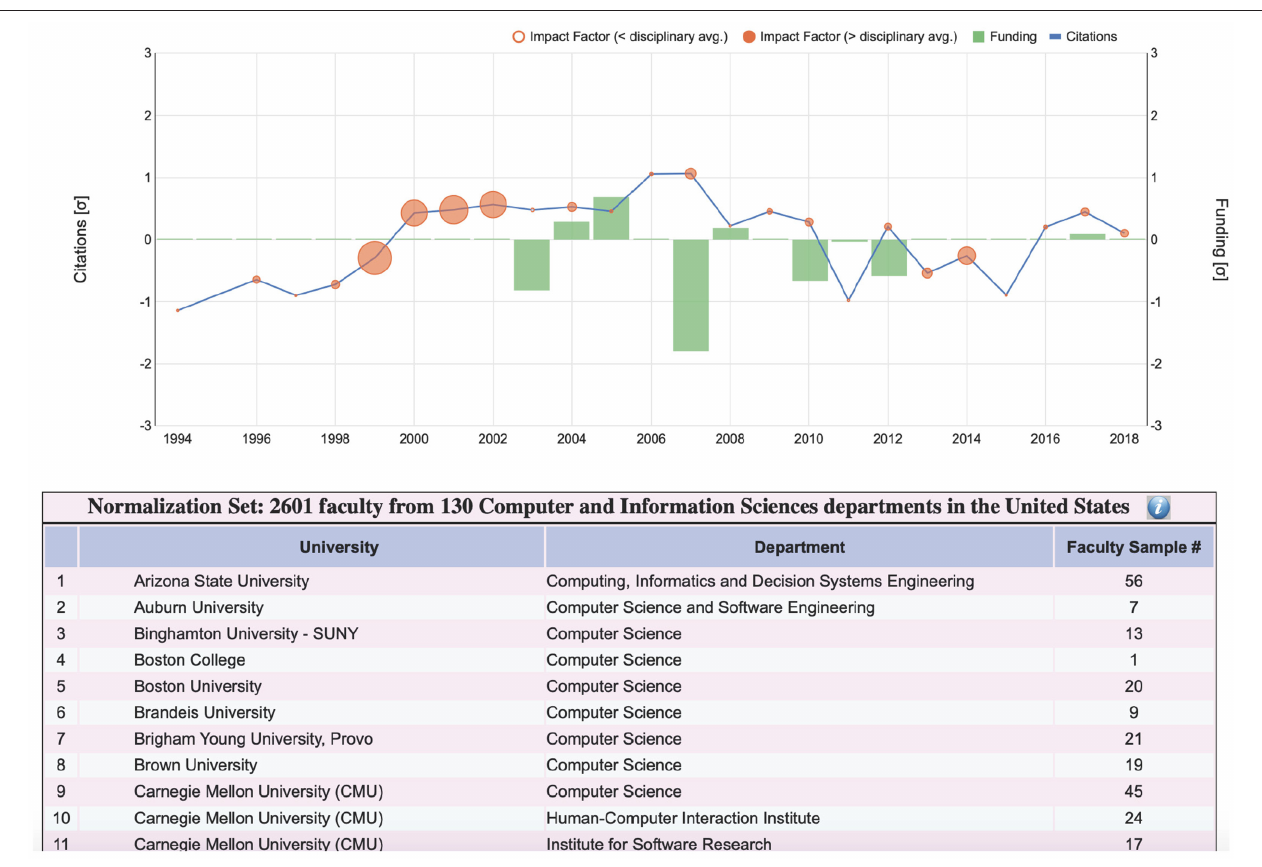
FIGURE 9 | Details of disciplinary sample used in the normalization equation for a computer science faculty whose SP plot is shown at the top. The departments partaking in the sample are listed alphabetically, complete with the corresponding faculty numbers in the database. Due to lack of space, only the first 11 out of 130 computer science departments are shown in this figure. In the actual SP interface, the user can scroll though the entire